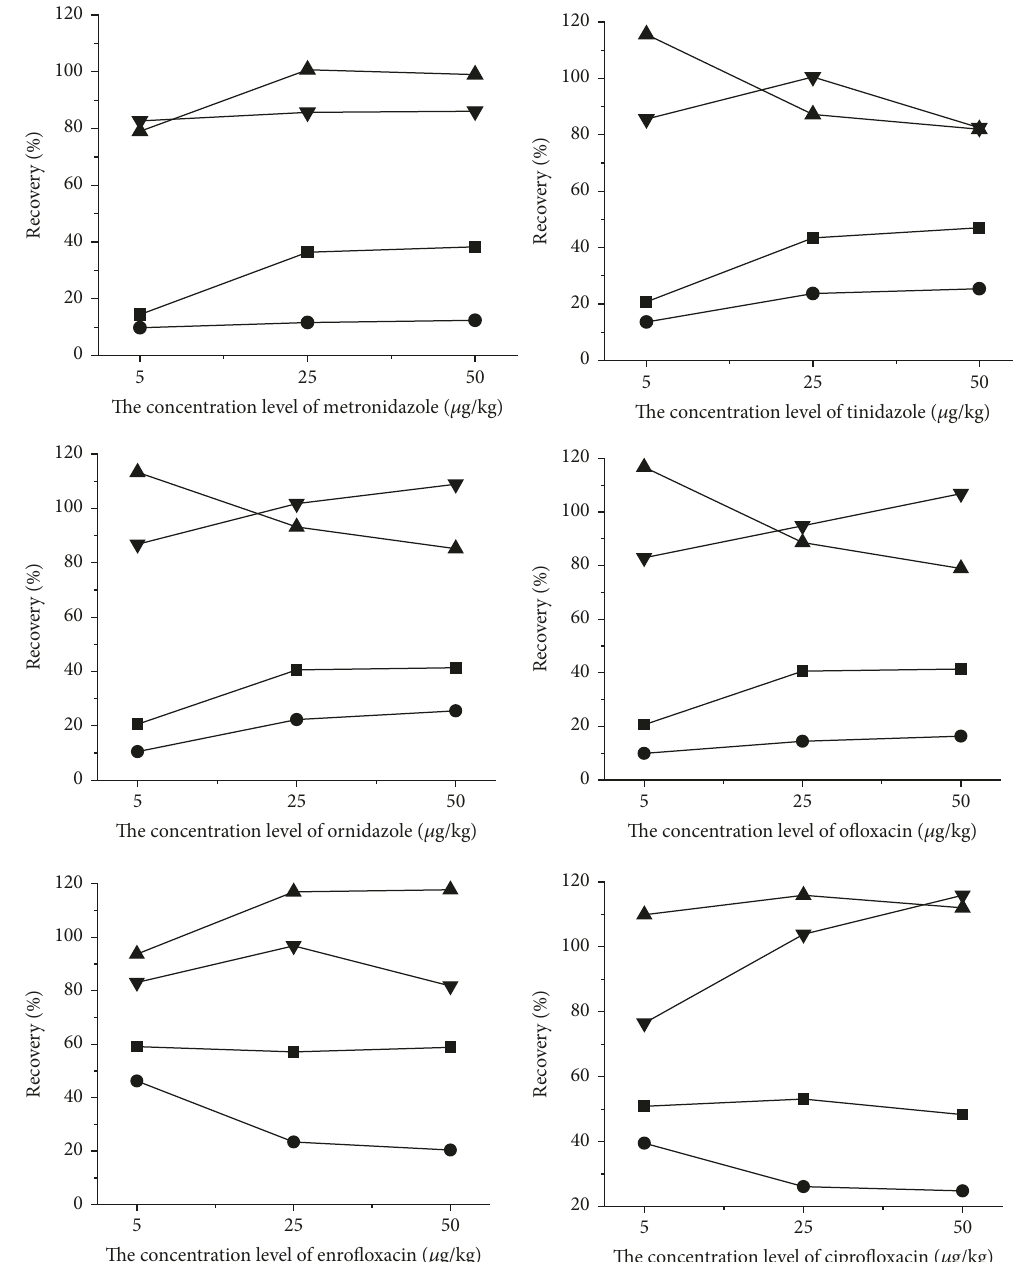
Figure 3: Absolute and relative recovery of target compounds. ◼ , e : the recovery rates of six kinds of drugs by the solution standard curve in acacia and jujube honey, respectively; 󳶃 , 󳵳 : the recovery rates of six kinds of drugs by the matrix standard curve in acacia and jujube honey,